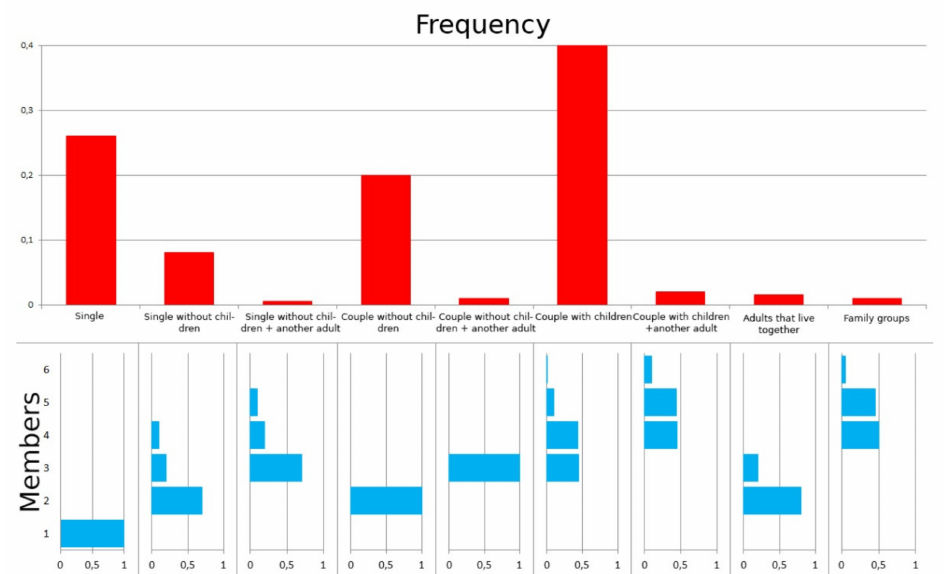
Figure 6. Family type distribution chart with relative number of